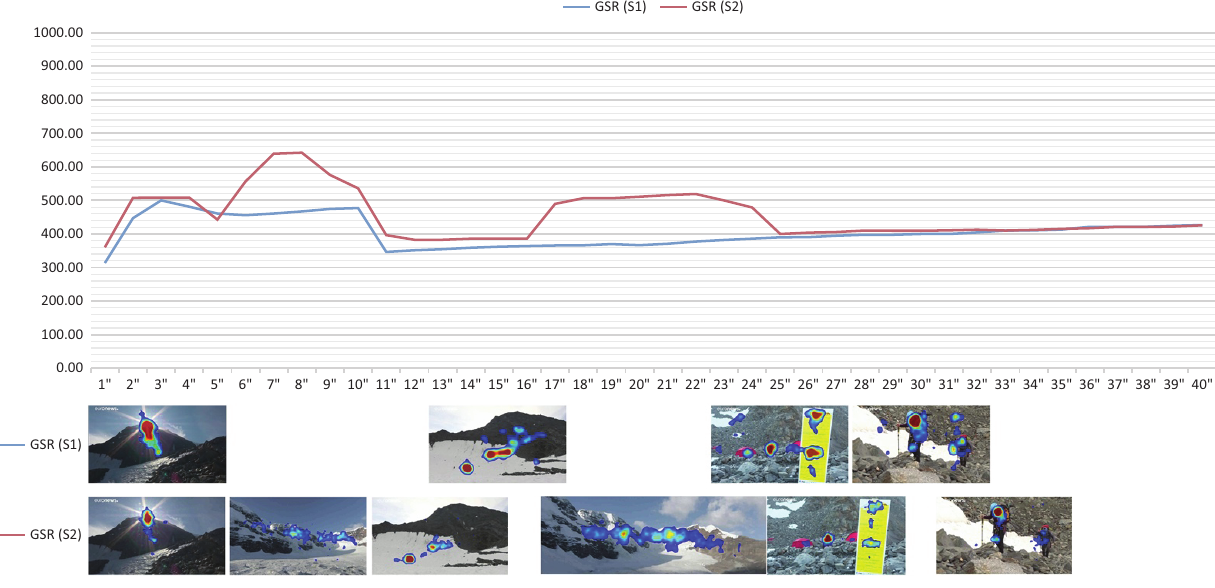
Figure 1. GSR peaks of the stimuli. Source: Euronews